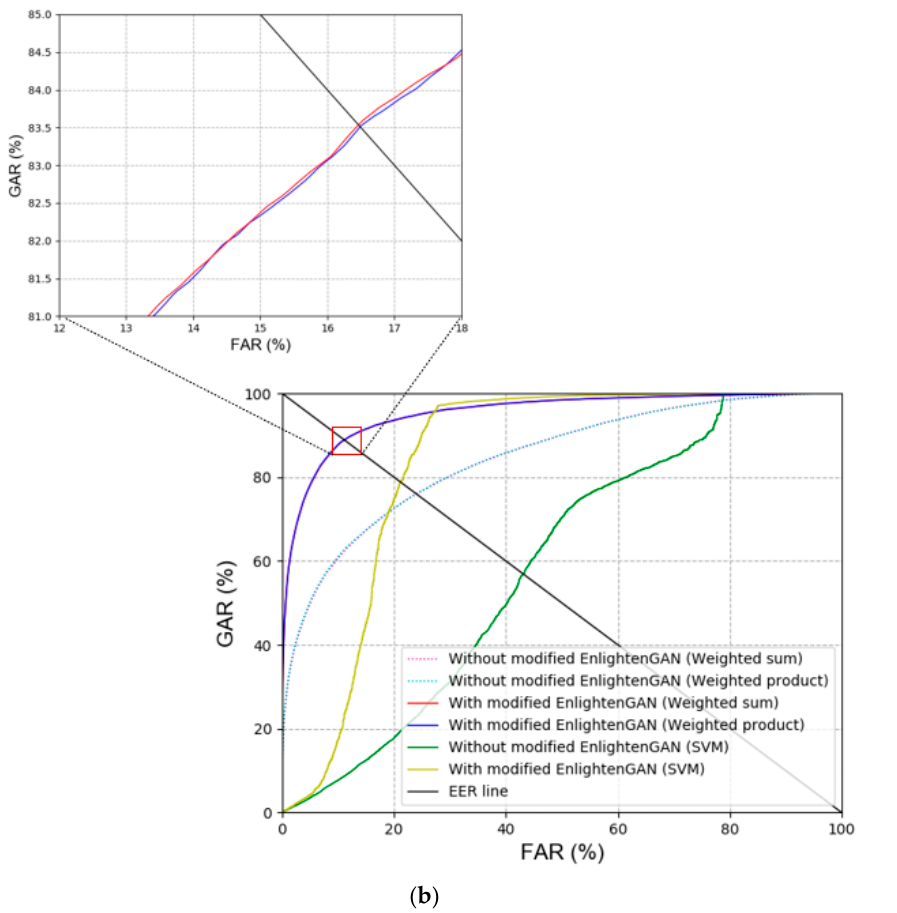
Figure 15. ROC curves of recognition accuracies with and without modified EnlightenGAN. Results of ( a ) face and body recognition, and ( b ) various score-level fusions. Table 13. Comparisons of EER for face and body recognition with and without modified Enlight- enGAN (unit: %).